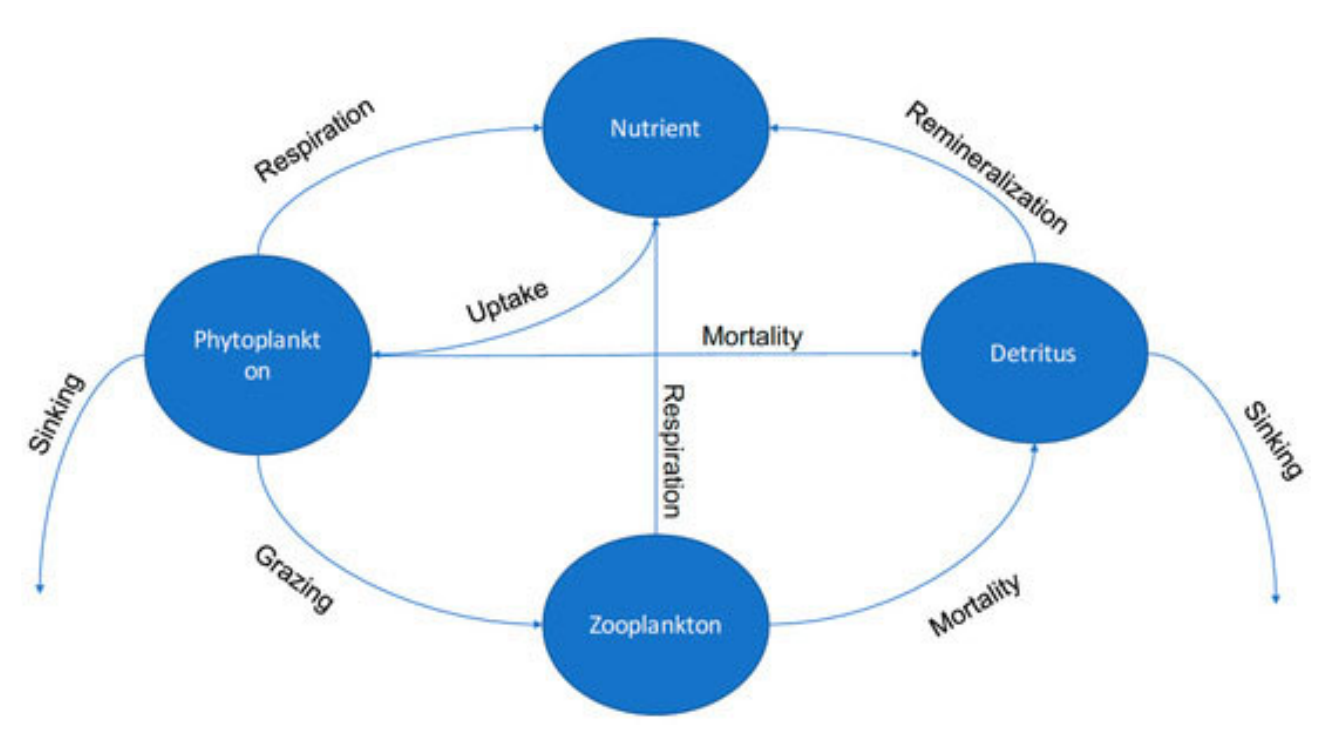
Figure 1. Diagram of the NPZD model. adapted with permission from Ref. [31]. Xue et al., 2018, Journal of Marine Science and Engineering.